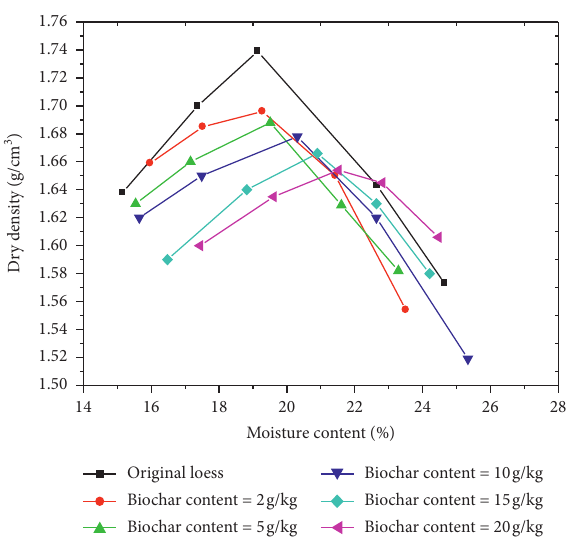
Figure 1: The variation of soil ρ